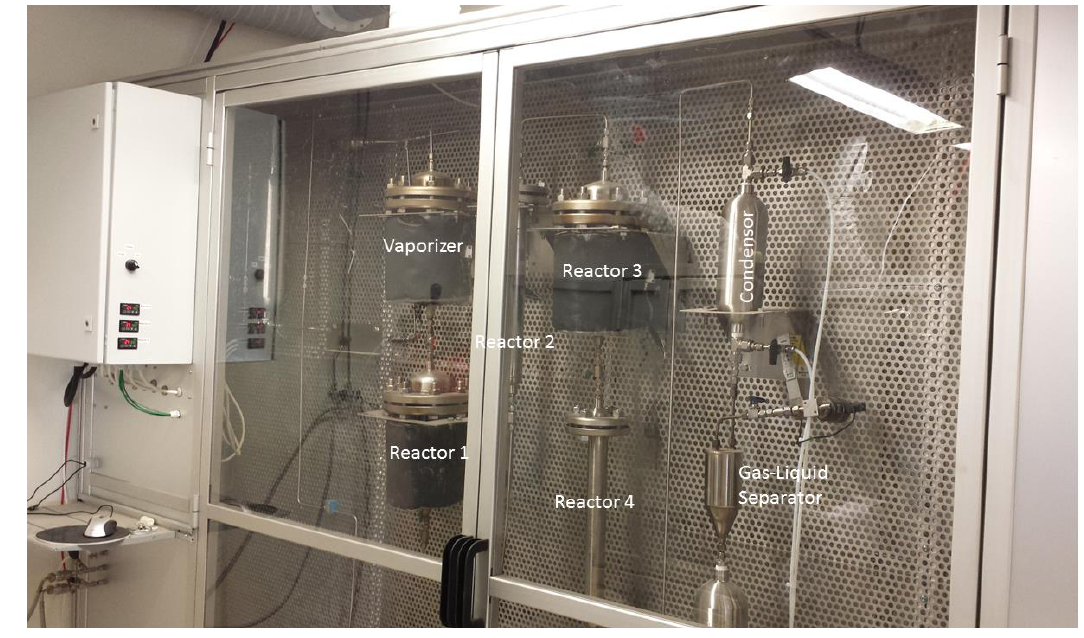
Figure 9. Skid-mounted finished process with a single vaporizer vessel.